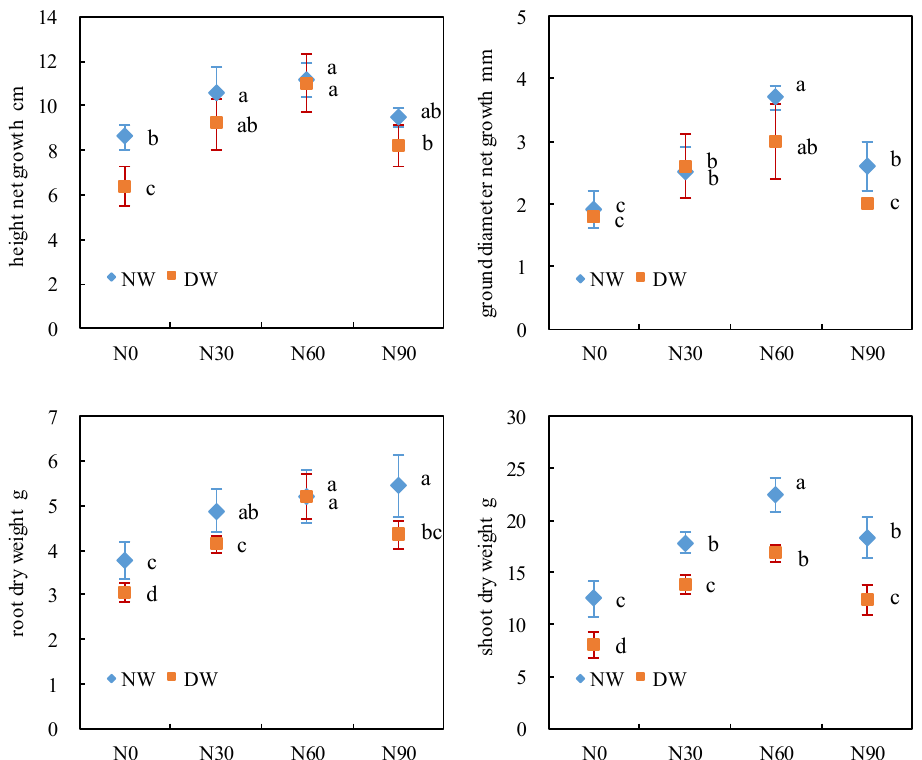
Figure 4. Effect of drought stress and nitrogen deposition on growth indicators. Water supply treat- ments: normal water supply (NW) or drought stress (DW) for 10 d or 30 d. Nitrogen deposition treat- ments: control (N0, 0 kg · hm − 2 year − 1 ), low nitrogen deposition (N30, 30 kg · hm − 2 year − 1 ), medium nitrogen deposition (N60, 60 kg · hm − 2 year − 1 ), or high nitrogen deposition (N90, 90 kg · hm − 2 year − 1 ). Data points represent means ± the SD; n = 5. Data points with the same lowercase letter are signifi- cantly different ( p < 0.05) according to Tukey’s